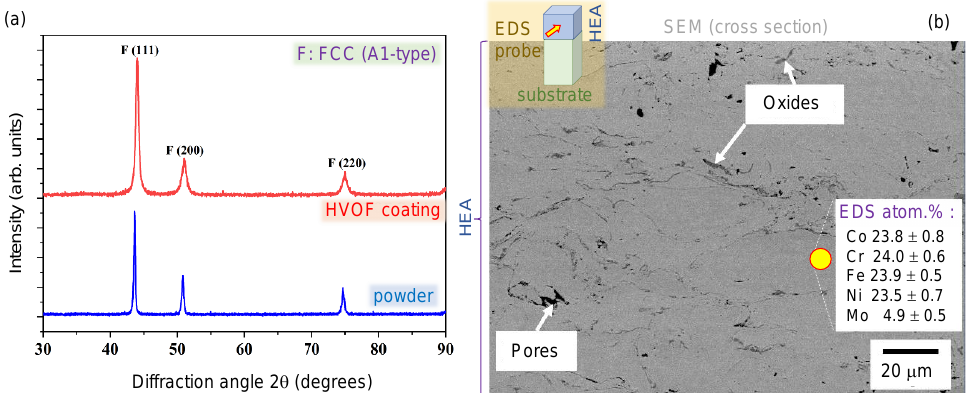
Figure 5. Thick HEA film deposited by high-temperature spray. ( a ) X-ray diffraction (XRD) of diffractograms of gas atomized CoCrFeNiMo 0.2 powder and HVOF sprayed coating (GTV HVOF K2, GTV Verschleißschutz GmbH, Germany). ( b ) The cross-sectional scanning electron microscopy (SEM) image of HVOF CoCrFeNiMo 0.2 coating along with EDS analysis of the coating phase in atomic